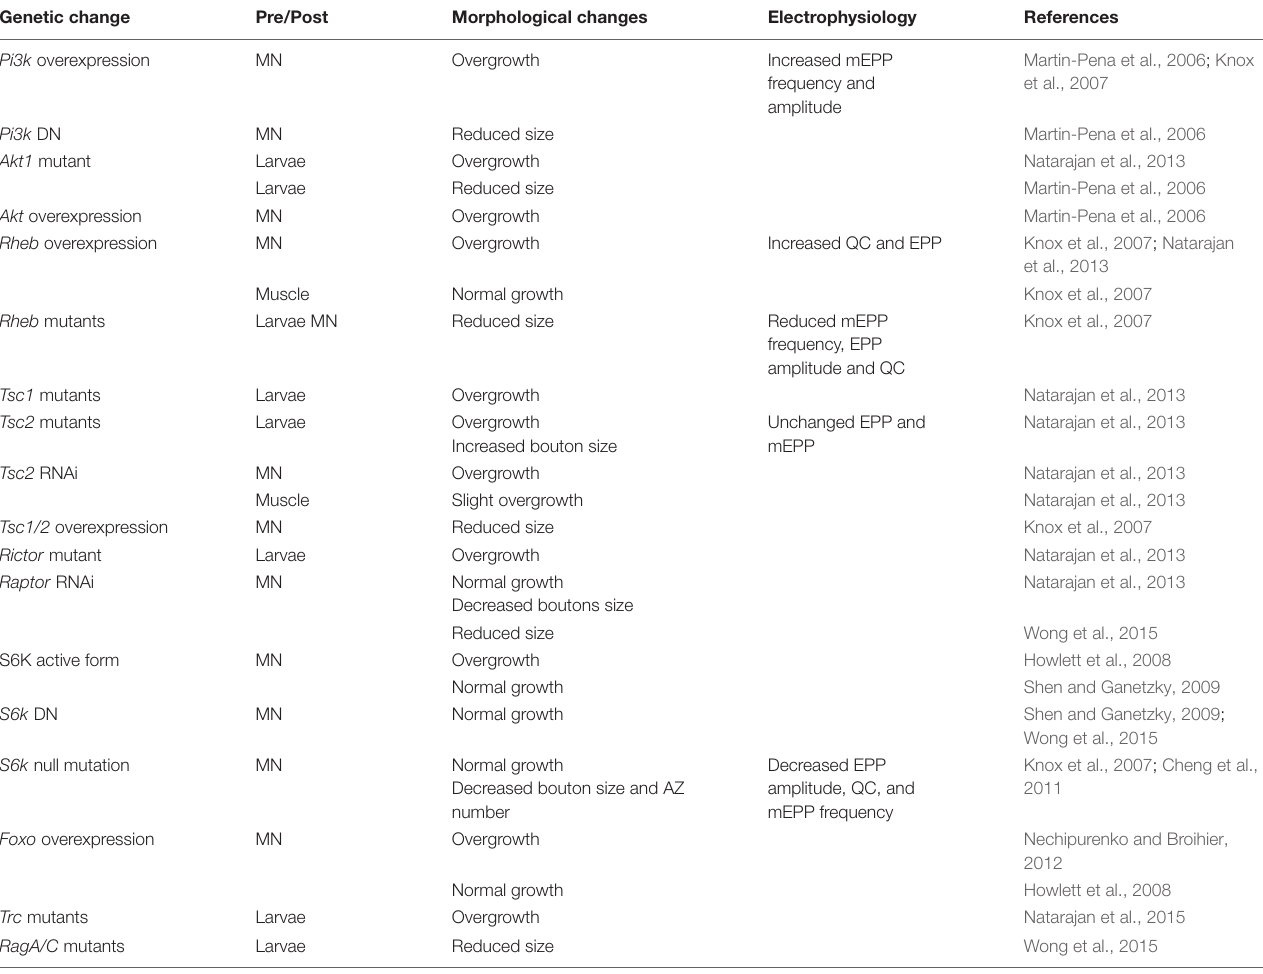
TABLE 1 | Modulation of the TOR pathway in Drosophila larvae and its effects on